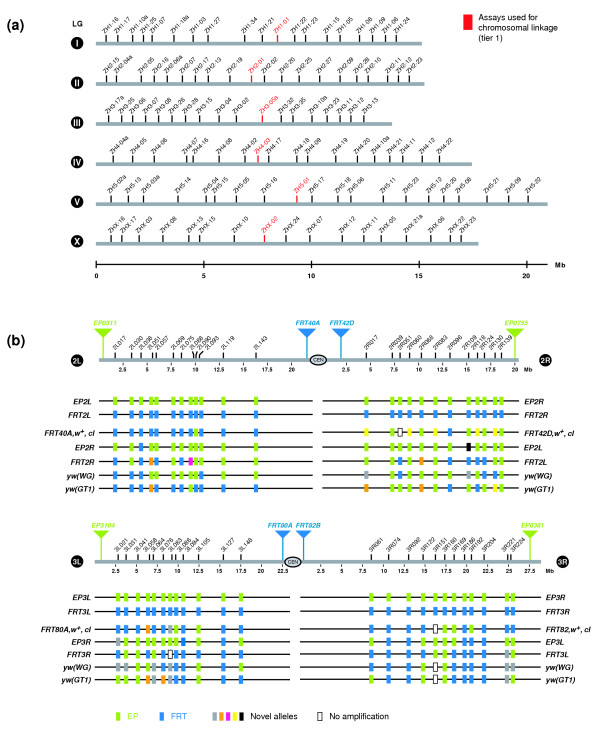
C. elegans and Drosophila FLP maps. (a) The C. elegans FLP map. Marker names comprise a ZH prefix followed by the chromosome number and a unique identifier number. Markers used in first-level assays (Tier 1) for determination of chromosomal linkage are in red, those used for second-level assays (Tier 2) for higher resolution mapping are in black. (b) The Drosophila FLP map of chromosomes 2 and 3. The FRT sites and EP elements are symbolized by blue and green triangles, respectively. The strains that were genotyped are shown below each chromosome. Green indicates the EP genotype, blue the FRT genotypes and new alleles are shown in other colors.